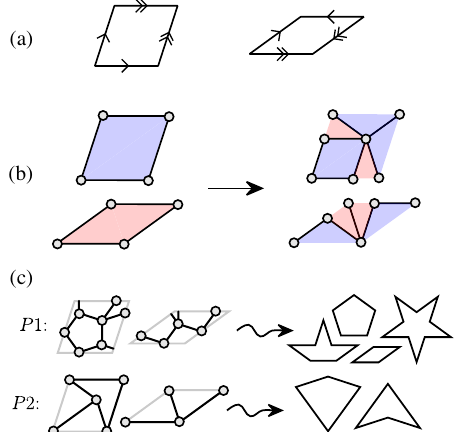
FIG. 3. The possible vertices in the P 2 dart-kite tiling (left), their equivalents in the P 3 rhombic tiling (middle), and the inflations of each (right). We label the P 3 vertices according to the number of edges connected to them. Tile matching rules distinguish the 5 vertices and are indicated; P 2 suns are labeled A;B according to the number of darts connected to them [53]. The P 2 vertices divide into two bipartite sublattices: star-queen-king-ace (black vertices) and deuce-jack-suns (white